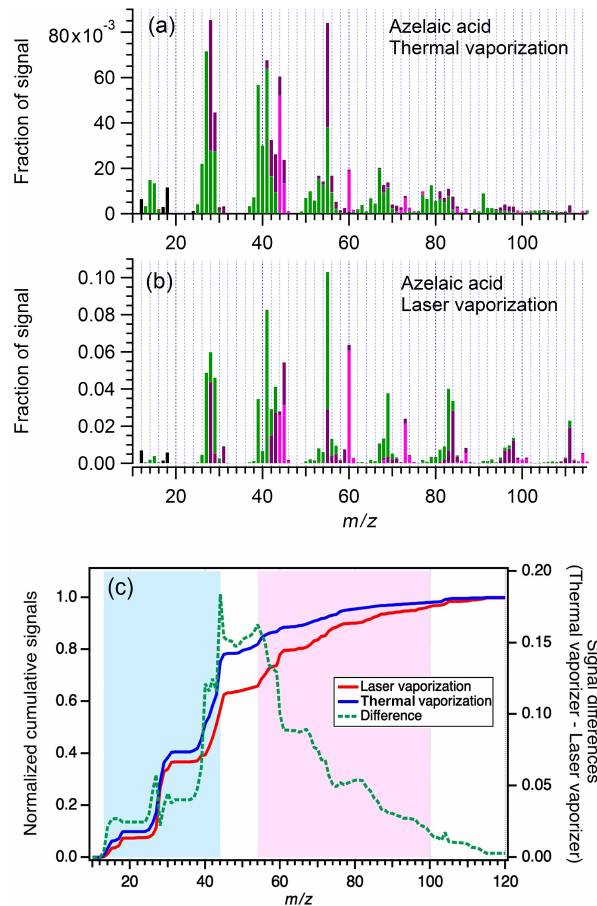
Figure 2. Mass spectra of azelaic acid, measured by SP-AMS 1 using the thermal (a) and laser (b) vaporization schemes. (c) Nor- malized cumulative histogram of mass-to-charge ratios for the oxy- genated organic compounds measured by the SP-AMS 1. The blue area indicates that the thermal vaporization scheme tends to provide organic fragments with smaller m/z , whereas the pink area indicates that the laser vaporization scheme tends to give organic fragments with larger m/z